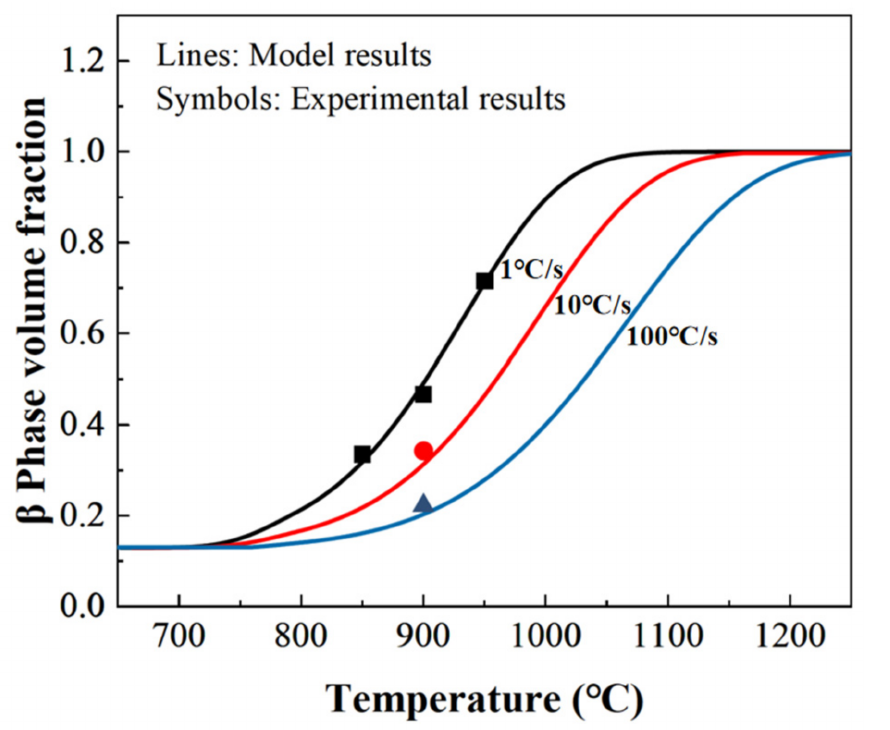
Figure 11. Comparisons of the experimental and modelling results on the volume fraction of the β phase at different heating rates and heating